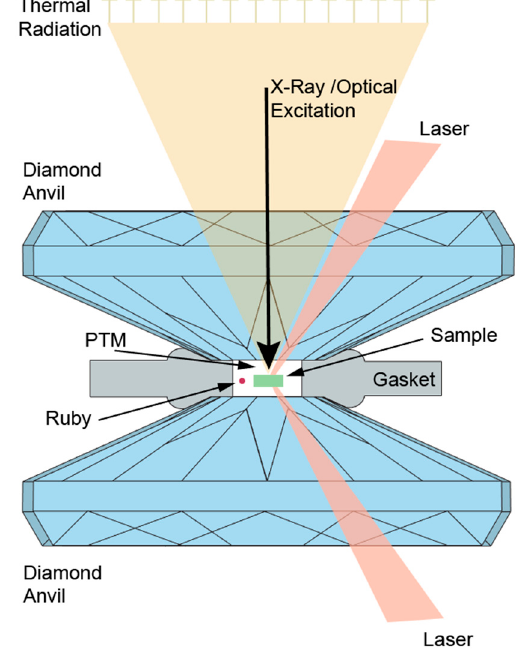
Figure 2. The principle of the laser ‐ heated diamond anvil cell (LH ‐ DAC).